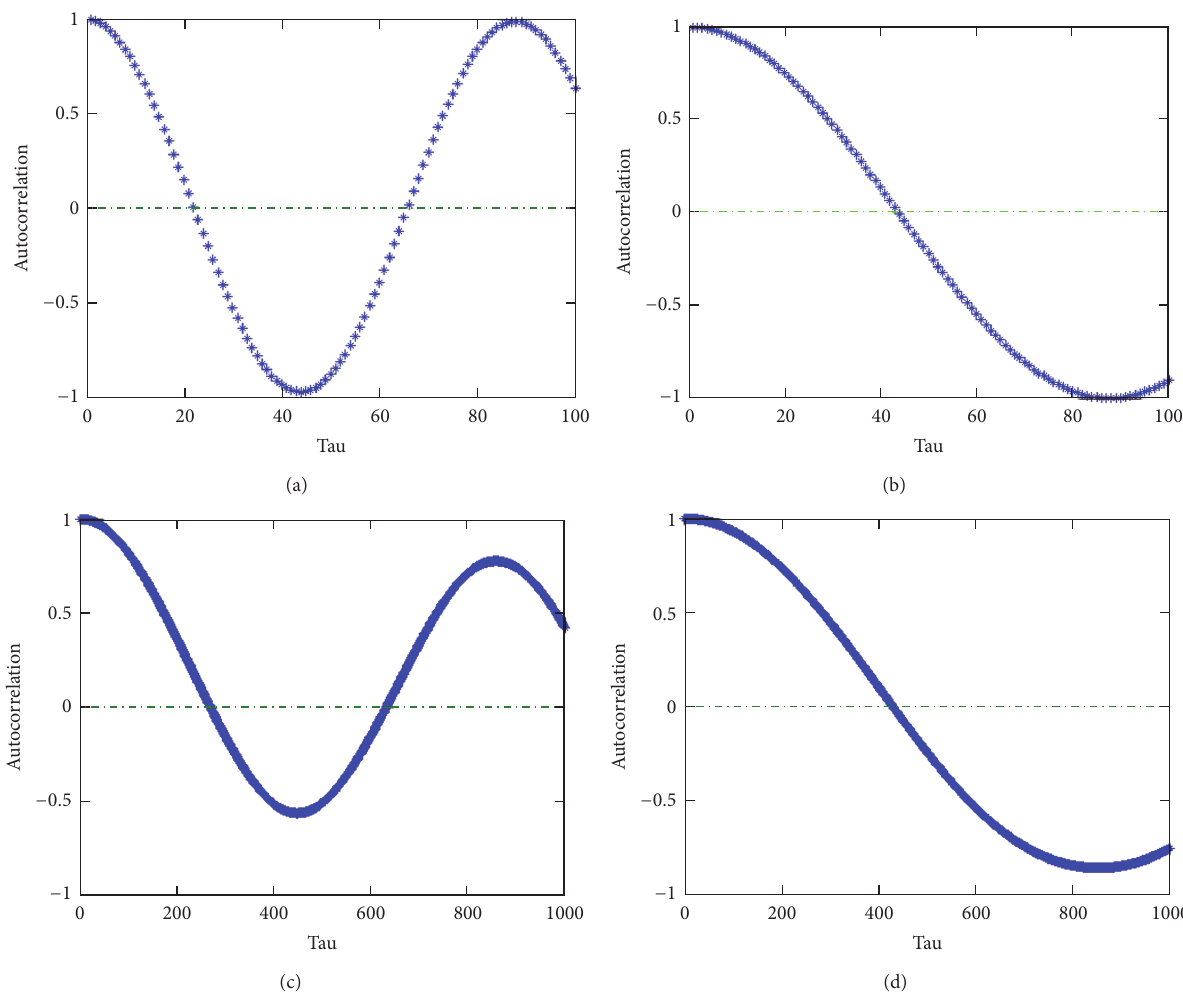
Figure 25: Autocorrelation of different mass velocity with damaged level is 10%, mass is 200 Kg, and sensor location is 𝐿 𝑠 = 0.5 : (a) mass velocity is V = 0.5 m/s, (b) mass velocity is V = 1 m/s, (c) mass velocity is V = 5 m/s, and (d) mass velocity is V = 10